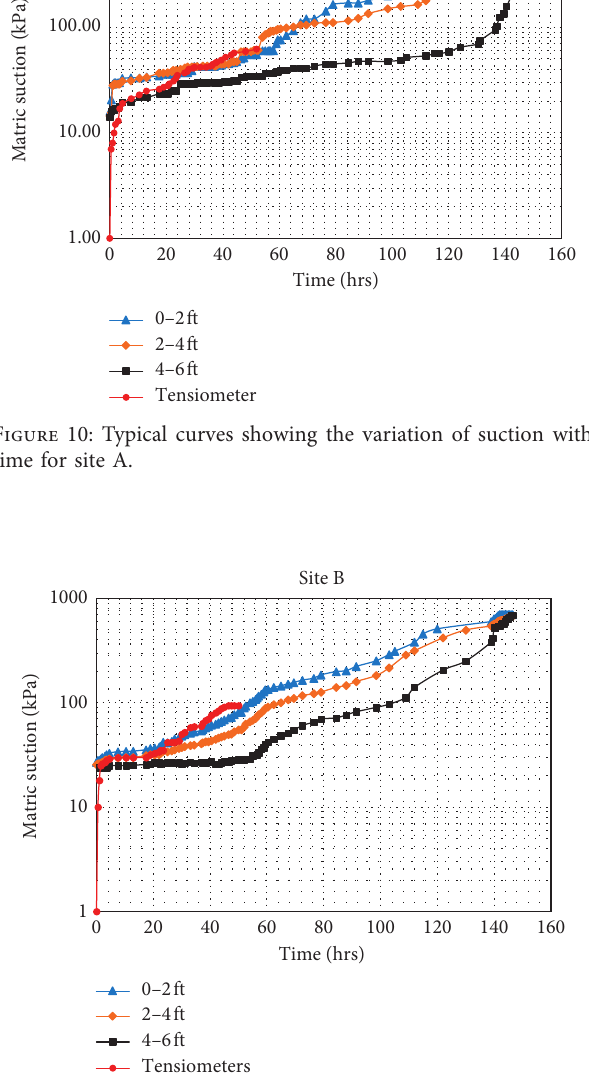
Figure 11: Typical curves showing the variation of suction with time for site B.